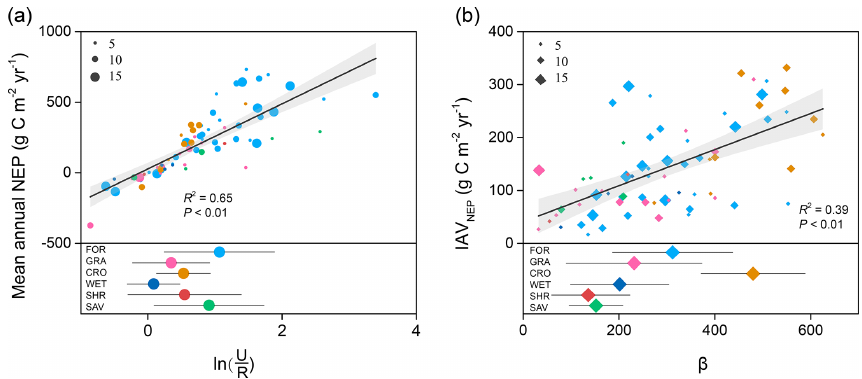
Figure 3. Contributions of the two indicators in explaining the spatial patterns of mean annual NEP and IAV NEP . (a) The relationship ) across FLUXNET sites ( R 2 = 0 . 65, P < 0 . 01). The insets show the magnitude of ln ( U between annual mean NEP and ln ( U R terrestrial biomes. (b) The explanation of β in IAV NEP ( R 2 = 0 . 39, P < 0 . 01). The insets show the distribution of parameter β for different terrestrial biomes. The number of years at each site is indicated with the size of the point.